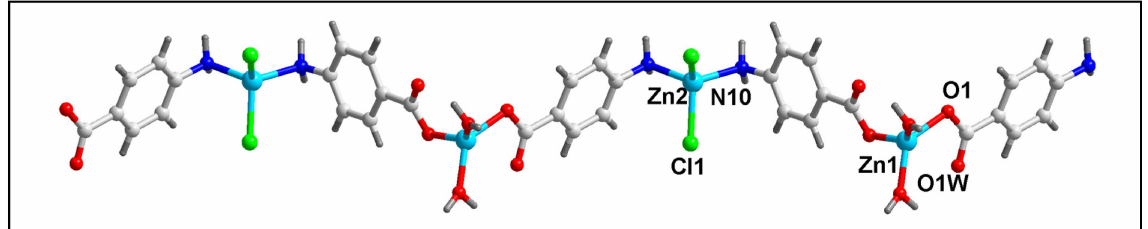
Figure 1. Molecular structure of [Zn 2 Cl 2 (H 2 O) 2 ( µ -4-AmBz) 2 ] n ( 1